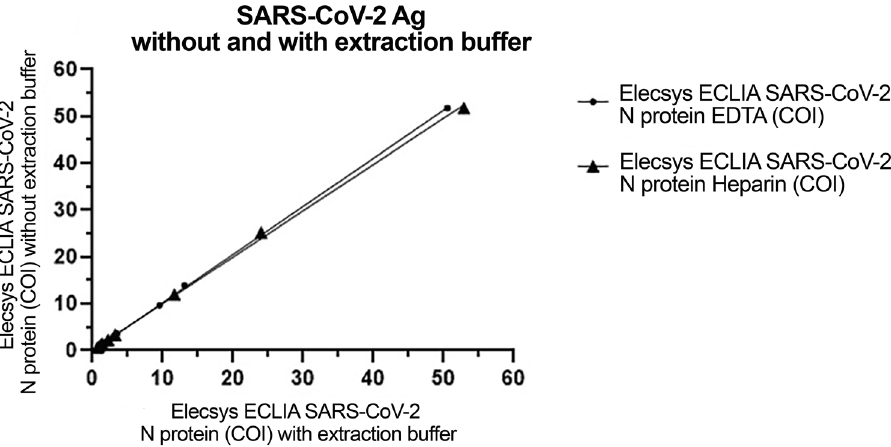
Figure 1. Elecsys ECLIA assay linearity with and without extraction buffer in 10 positive and 10 negative matched EDTA and Heparin plasma